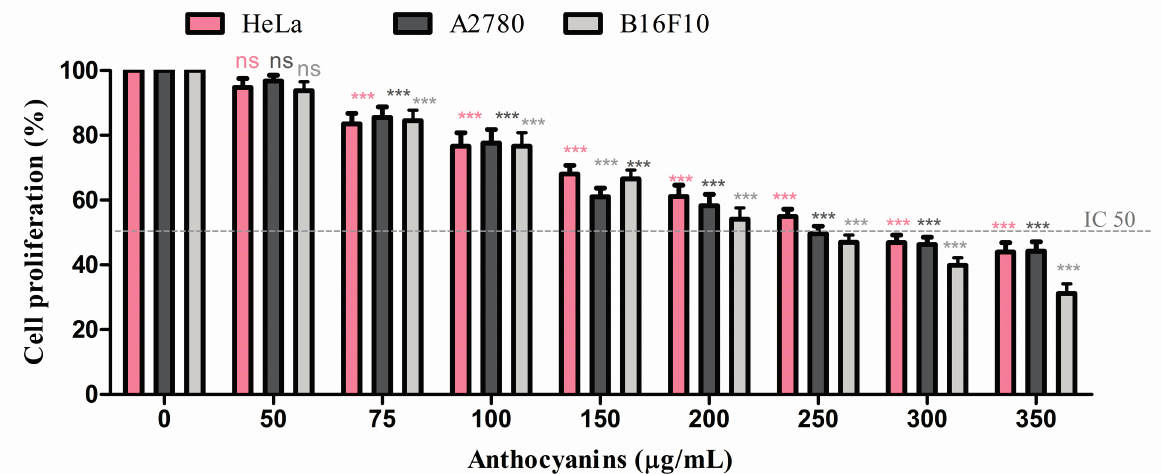
Figure 4. The antiproliferative effect of blackcurrant ARFs on cancer cell lines Statistical analysis was done using Dunnett multiple comparison test of Graph Pad Prism version 5.00. Data represent the means ± SD of at least three independent experiments (ns, none significant, *** extremely significant p <